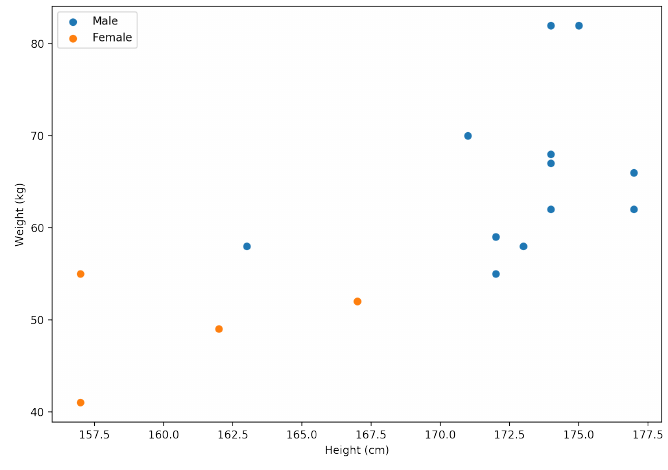
Figure 11. Weight and height of subjects.